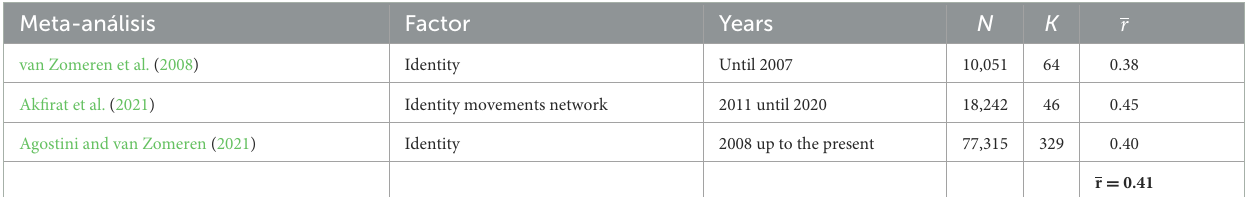
TABLE 5 Relationship of identity with SM and